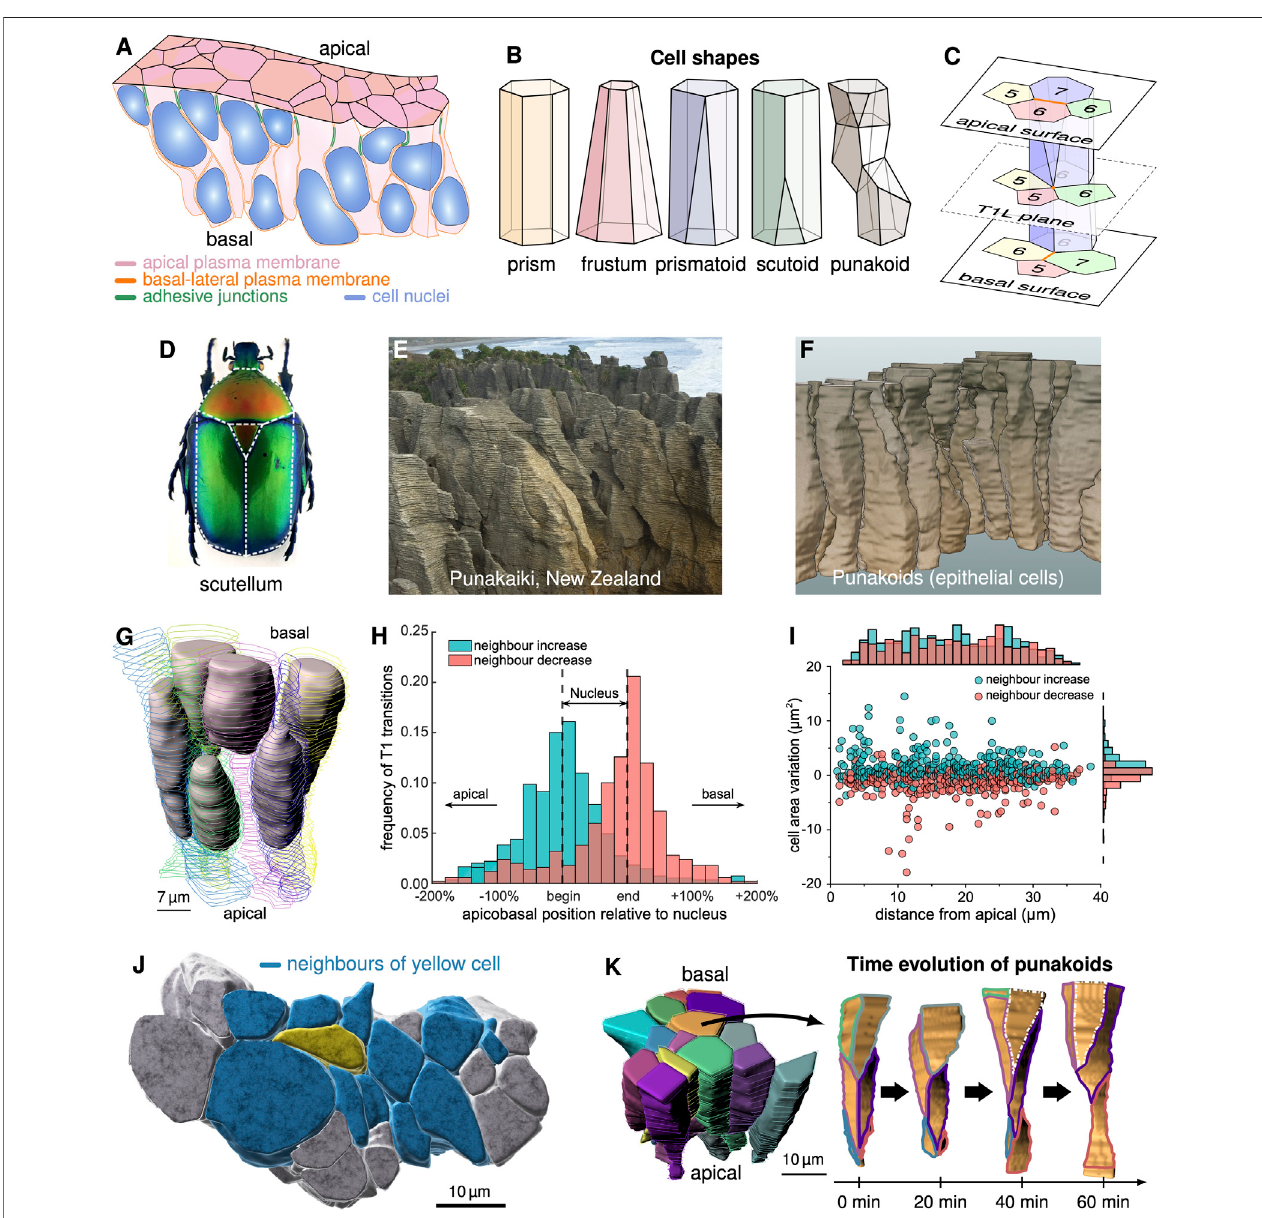
FIGURE1| 3Depithelialcellshapes. (A) Pseudostrati fi edepitheliumwithcellboundarieswrappingaroundwidernuclei. (B) Schematicdepictionofcellshapes. (C) Cellsaltertheirneighbourarrangements via T1Lprocessesalongtheapical-basalaxis.InaT1Lprocess,twoverticesthatshareanedge(orange)mergeanddecompose in a different direction such that neighbour relationships change. (D) The term scutoid was coined based on the shape of beetle scutum, scutellum and wings. (E) Pancake rocks at the beach of Punakaiki, NZ. (F) 3D segmented cells in the developing pseudostrati fi ed mouse lung epithelium (E12.5) resemble the Punakaiki rocks. (G) 3D shapes of 6 cells and their nuclei in an E12.5 pseudostrati fi ed mouse lung epithelium. (H) Neighbour relationships change predominantly at the apical and basallimitsofthenuclei. (I)